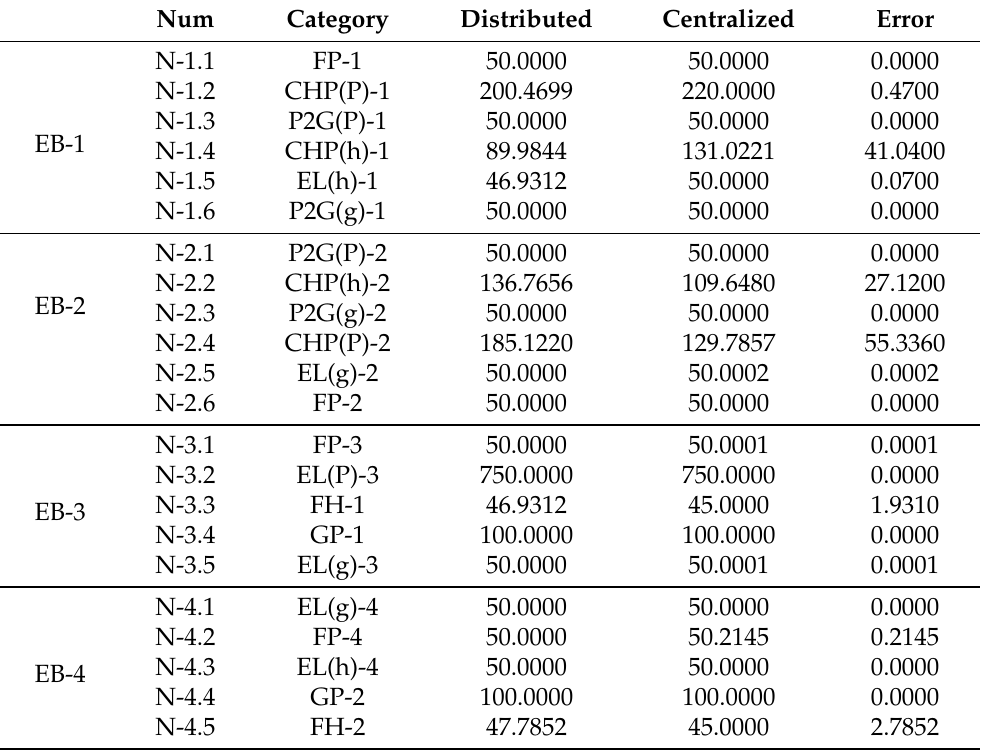
Figure 3. Energy generations and incremental costs of the test system. Table 3. Energy output/load demand results between two